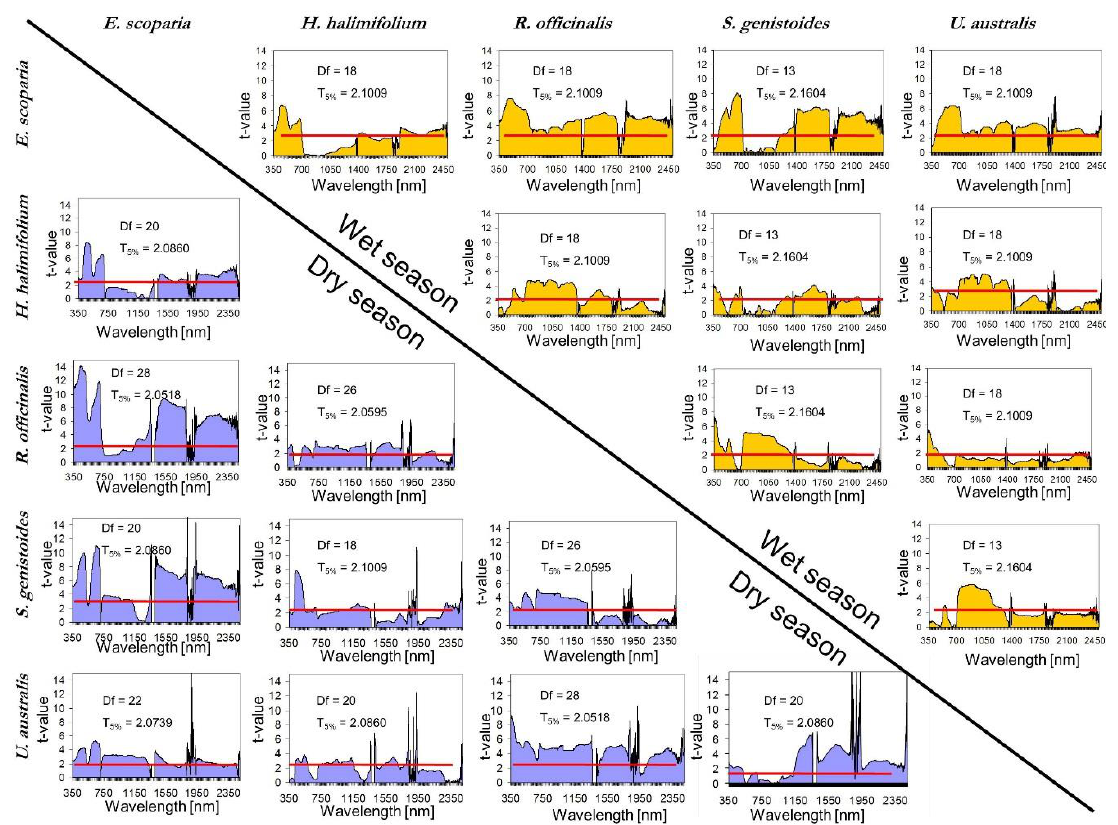
Figure 5. Intra-species variability for the DNP shrubland dominant species. t-test for species-to-species comparison for dry and wet season separately. The red line in the graphics identifies t-critical values according to the corresponding degrees of